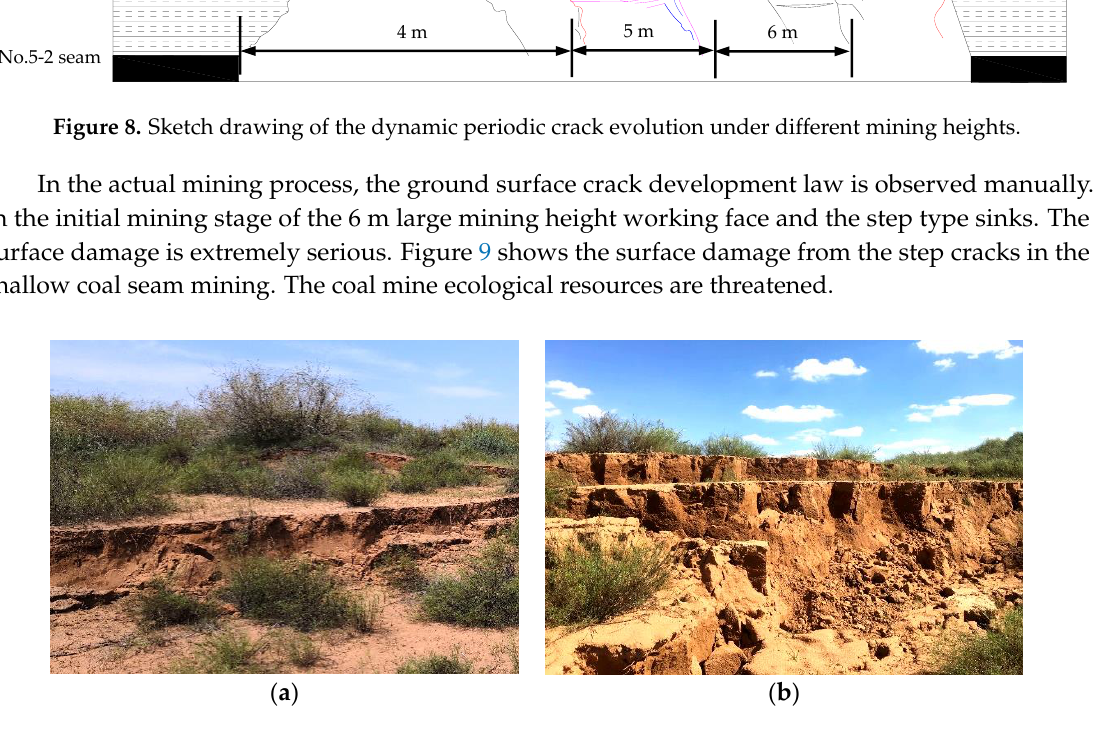
Figure 9. Surface damage from the step cracks: ( a ) step crack, and ( b ) the height of step crack is 1.6 m.